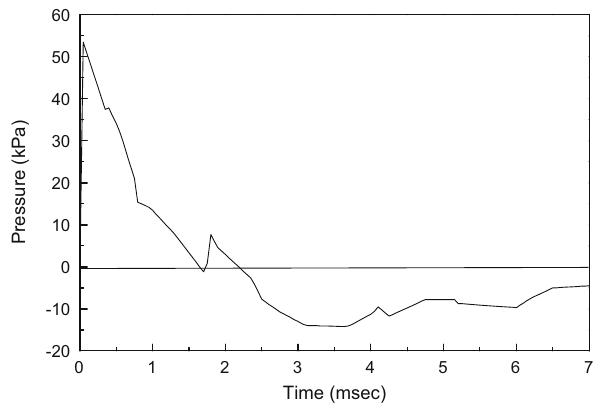
Figure 3: Time variation of average pressure due to air blast on a square